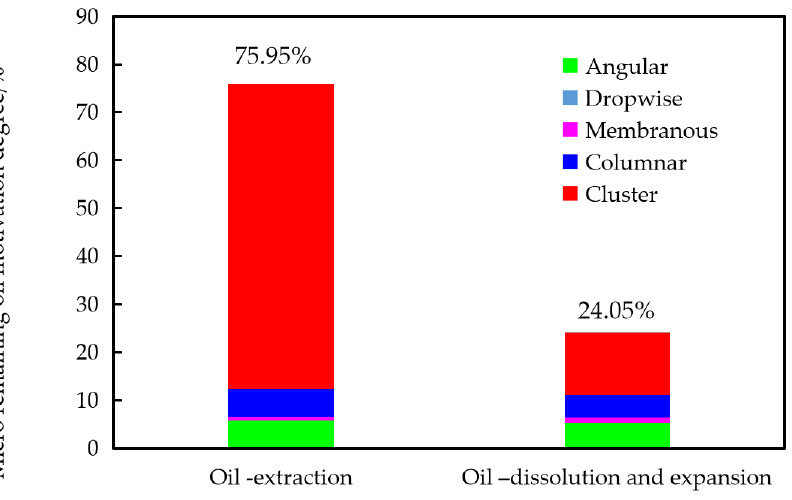
Figure 9. Mobilization degree of remaining oil under different